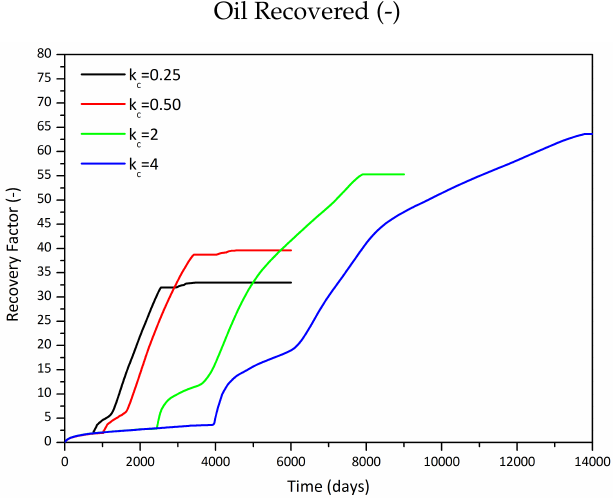
Figure 13. Permeability random fields [mD] with normal distribution in X ( left ) and Y ( right ) axes.